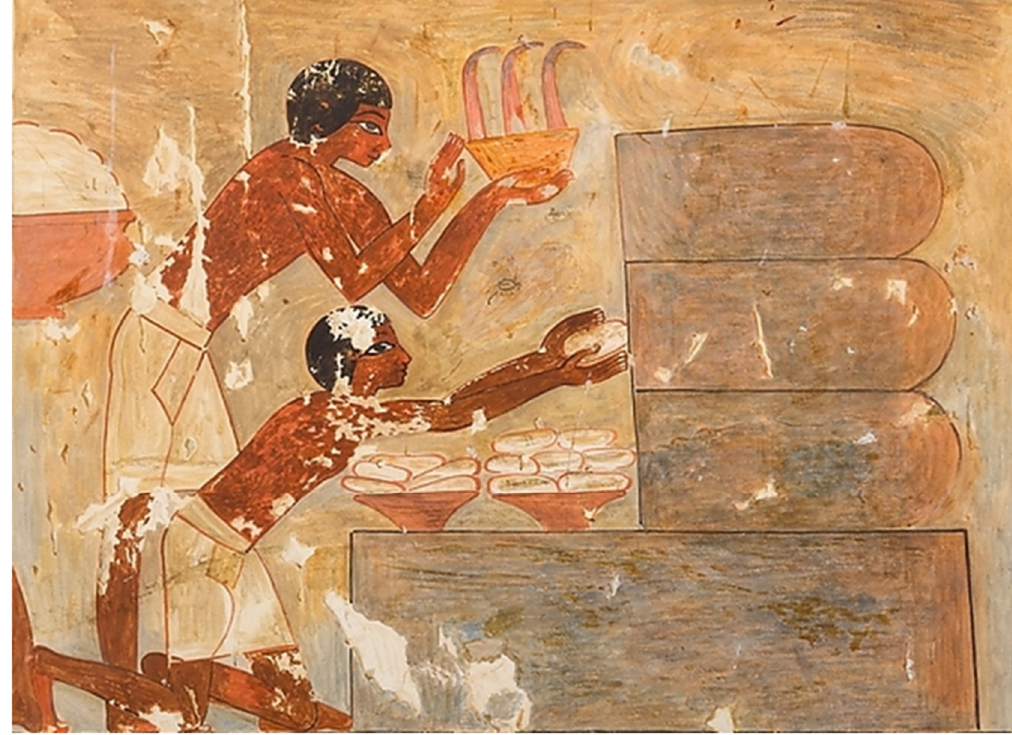
Figure 1. Honey combs gathering from large horizontal hives in Rekhmira tomb.